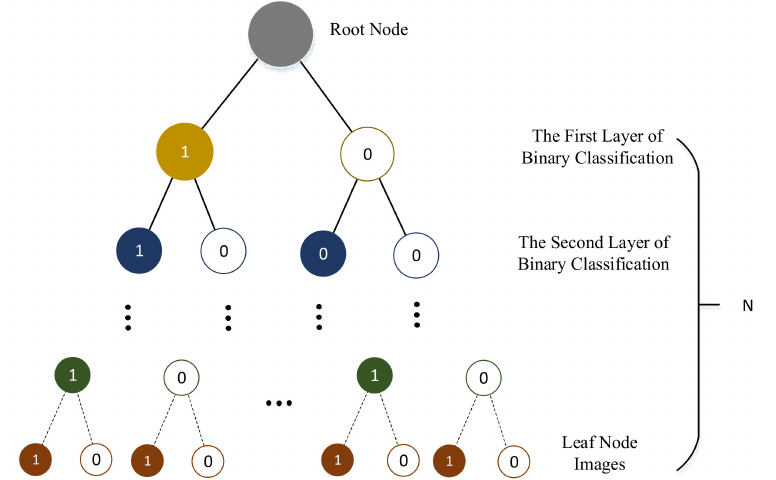
Figure 5. This is the structure of the Binary Classified Tree. Schemes follow the same formatting. Different colors represent the binary classification results of different labels; 1 indicates this label is present, 0 indicates this label is not present. The depth of the tree is the total number N of categories of object detection.